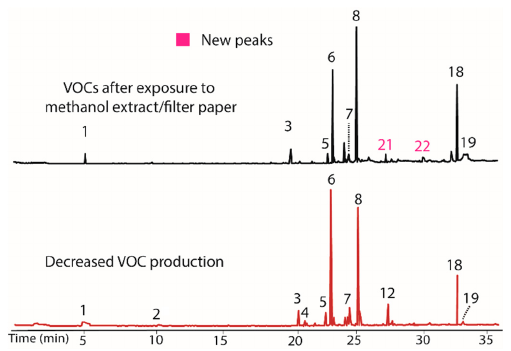
Figure 3. Chromatograms showing the negligible influence of the methanol extract/filter paper on VOC production in BS15. The new peaks ( 21 and 22 ) observed upon treatment ( top ) also occur in the control containing only filter paper. Their occurrence is therefore attributed to a change from the filter paper rather than the presence of VOC production modifiers extracted by methanol. The bottom plot illustrates BS15 after prolonged in vitro growth.